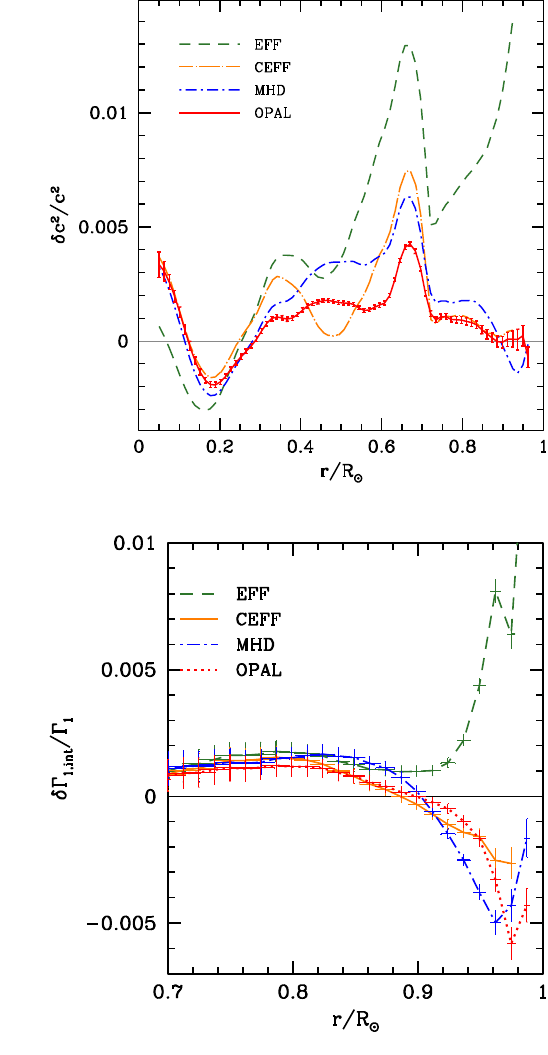
Fig. 22 The intrinsic Γ 1 differences between four different equations of state and the Sun. These were obtained by inverting Eq.